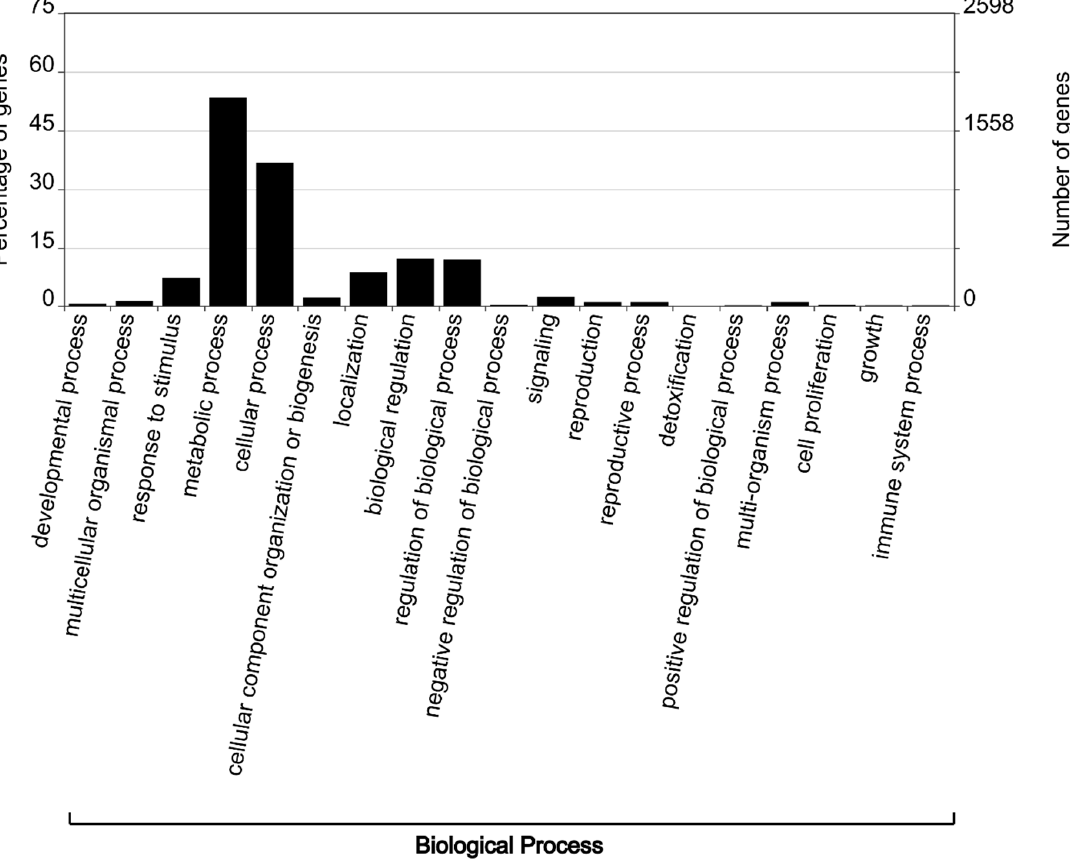
Figure 3. A representation of Gene Ontology analysis demonstrates the percentage of di ff erentially expressed genes enriched within the biological process category.